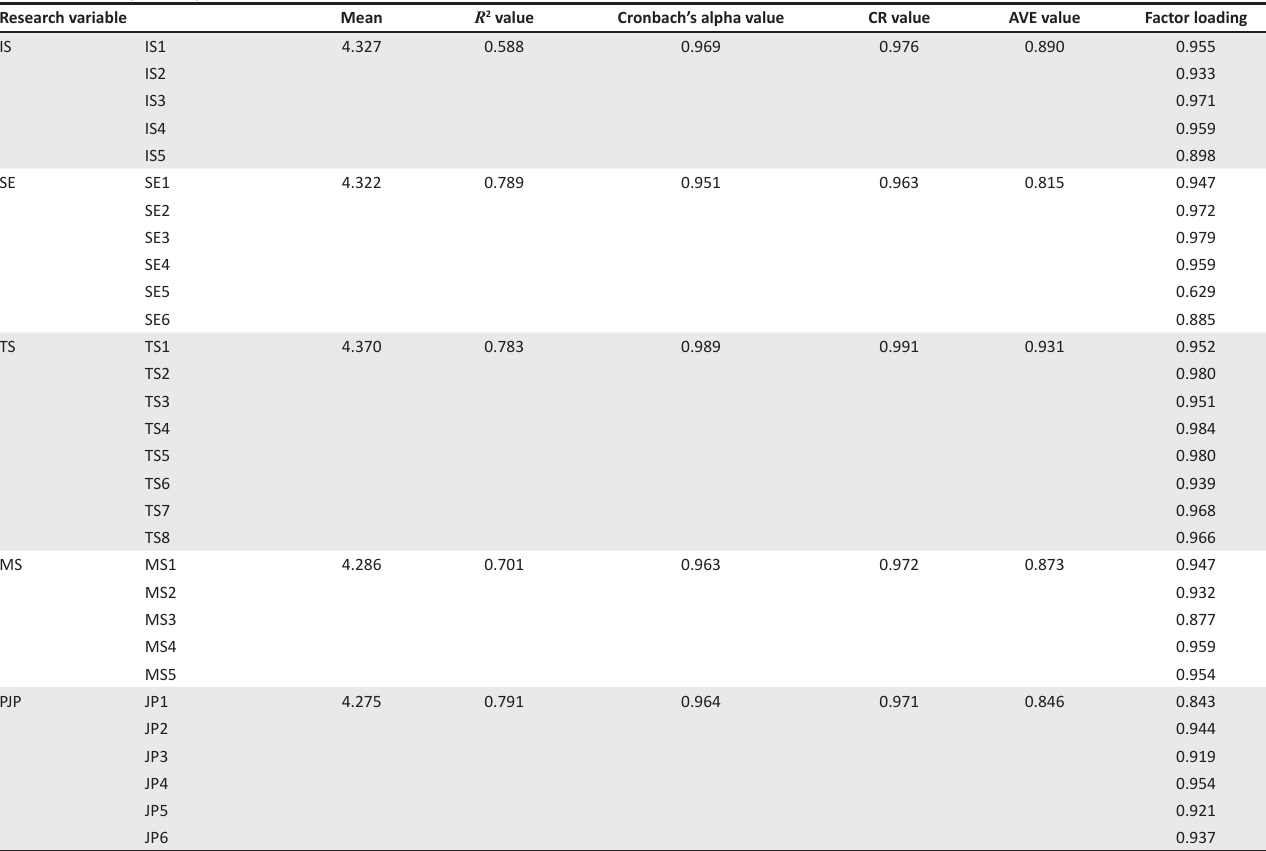
TABLE 5: Accuracy of analysis statistics. Research variable